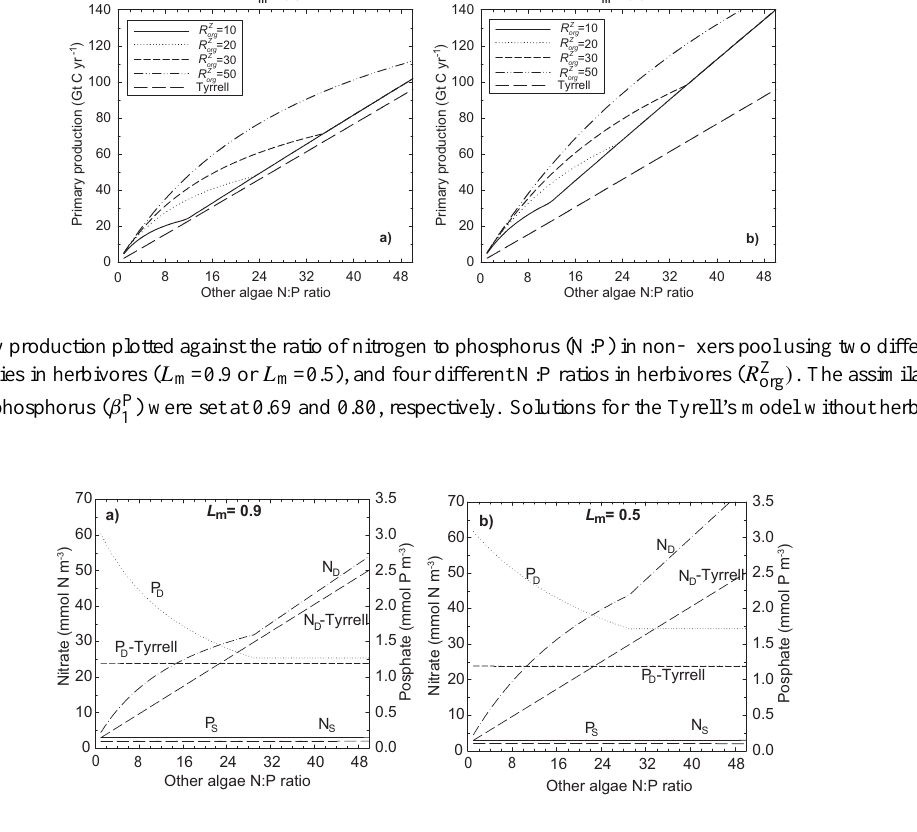
Fig. 7. Nutrient concentrations plotted against the N:P ratio in non-fixers using the default parameters set listed in Table 1, except for L m .